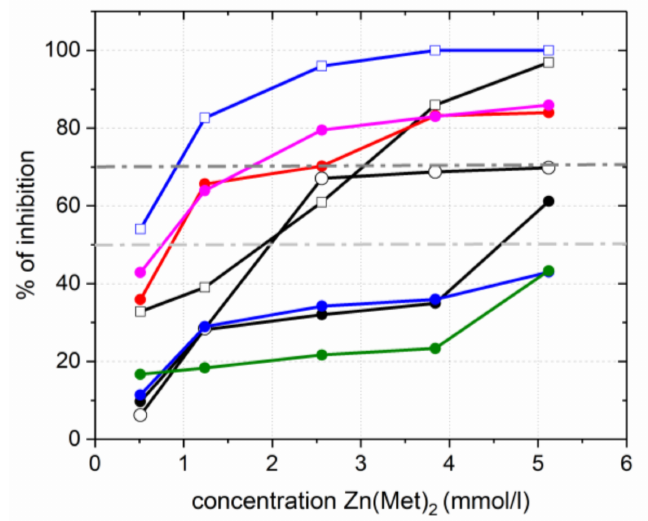
Figure 7. Antibiofilm activity of zinc methioninate complex, Staphylococus aureus 1449 —circle black, Staphylococcus aureus ATCC 6538 —unfilled square black, Staphylococcus simulans 5882 —unfilled circle black, Escherichia coli M17 —circle blue, Escherichia coli ATCC 25922 —unfilled square blue, Streptococcus agalactiae 3984 —circle red, Enterococcus cloacae 6392 —circle green, Acinetobacter bauman- nii 5841 —circle